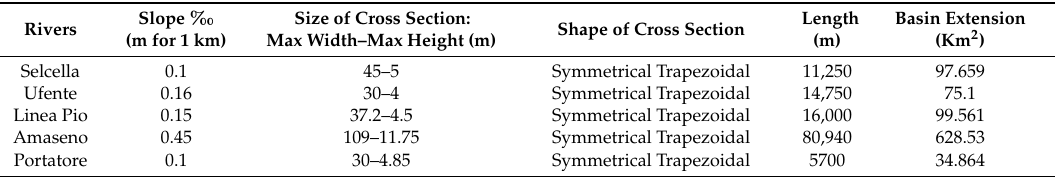
Table 2. Hydraulic characteristics of channels, rivers, and basins (data provided by Agro Pontino